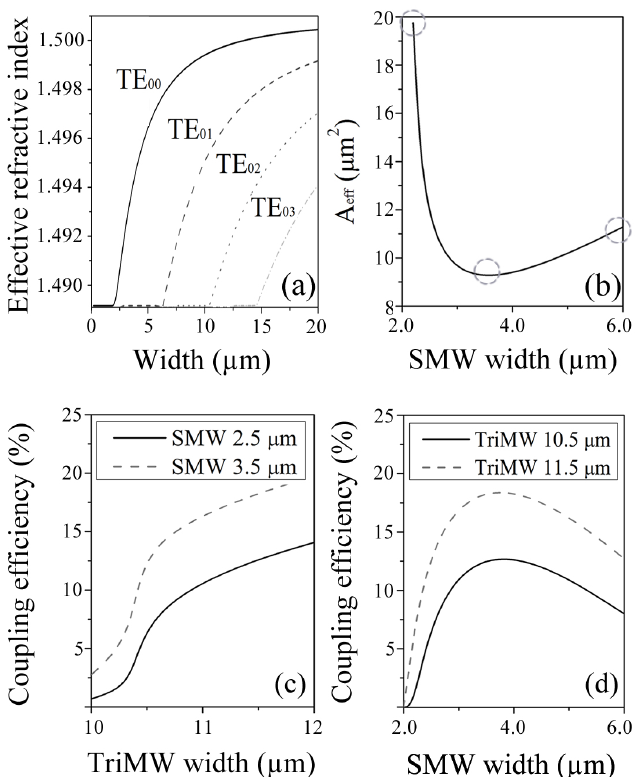
Figure 2. ( a ) Cutoff analysis for 600nm height waveguide. ( b ) Effective area analysis as function of the width variation in a single mode section waveguide at the single channel modal interferometer with 600nm height, working at 1550nm wavelength. Analysis of the percentage of energy coupled in the second order mode as function of the width variation in a ( c ) single mode section and in the ( d ) multimode section, at the same